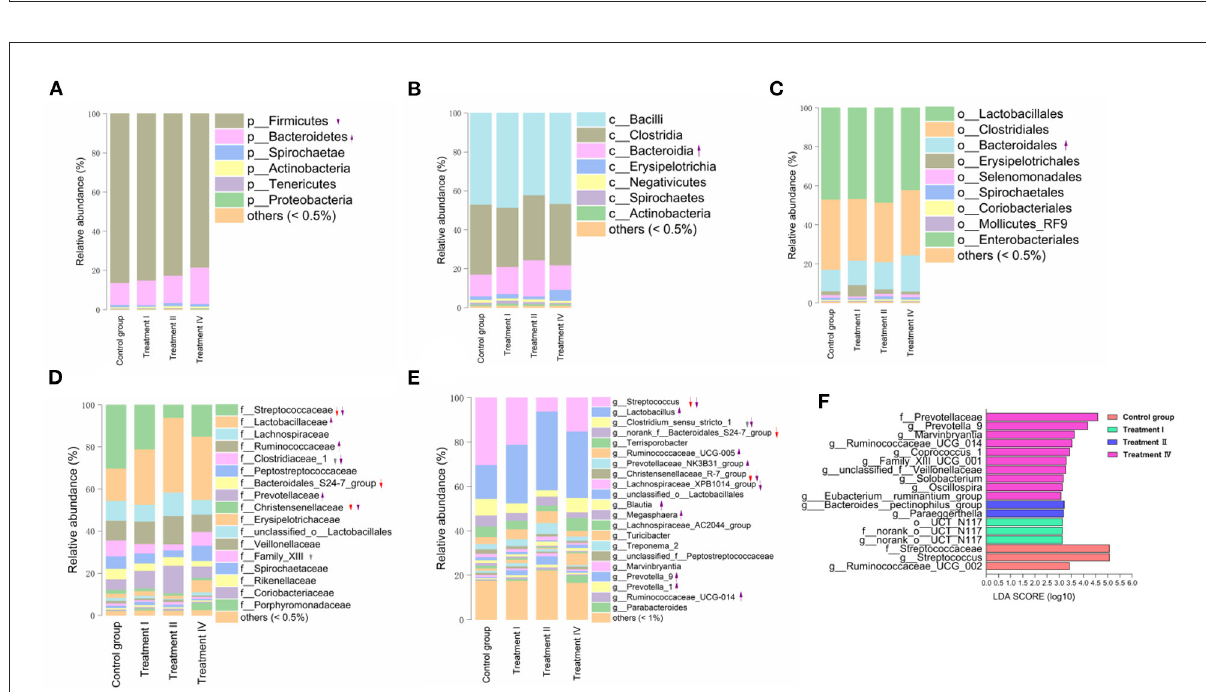
FIGURE3 Shifts in fecal microbial composition of pigs at phylum (A) , class (B) , order (C) , family (D) , and genus (E) levels as the increase of dietary fiber. The LEfSe analysis of intestinal bacterial communities (F) . Upward and downward arrows with solid line in (A–E) mean that the proportions of the corresponding microbial taxa significantly increased or decreased, compared with those in the control group, respectively ( p < 0.05). The arrows with dotted line in (A–E) mean that the relative abundance of the corresponding microbial taxa has increased or decreased trend, respectively ( p < 0.10). Red arrows mean comparison of treatment I vs. the control group. Gray arrows mean a comparison of treatment II vs. the control group. Purple arrows mean comparison of treatment IV vs. the control group. Letters p, c, o, f and g at the head of the names of taxon represent phylum, class, order, family and genus,